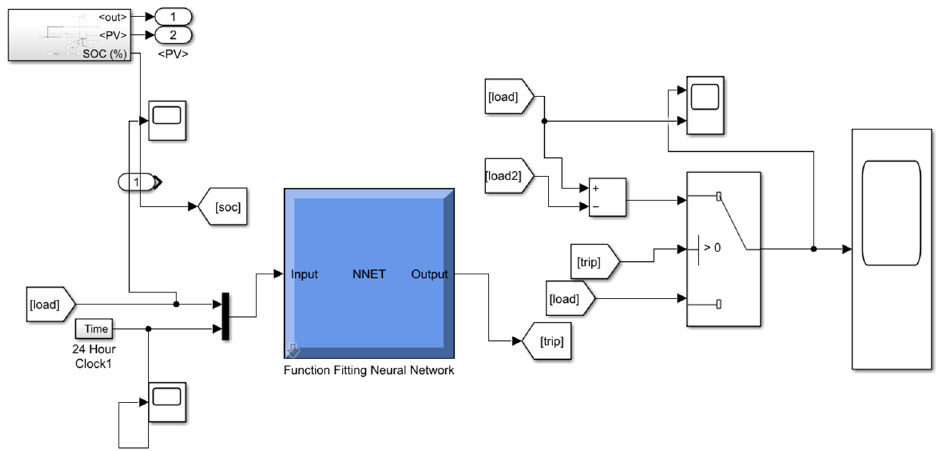
Figure 9. Simulink energy management model through peak clipping (PC) using a neural net- work.